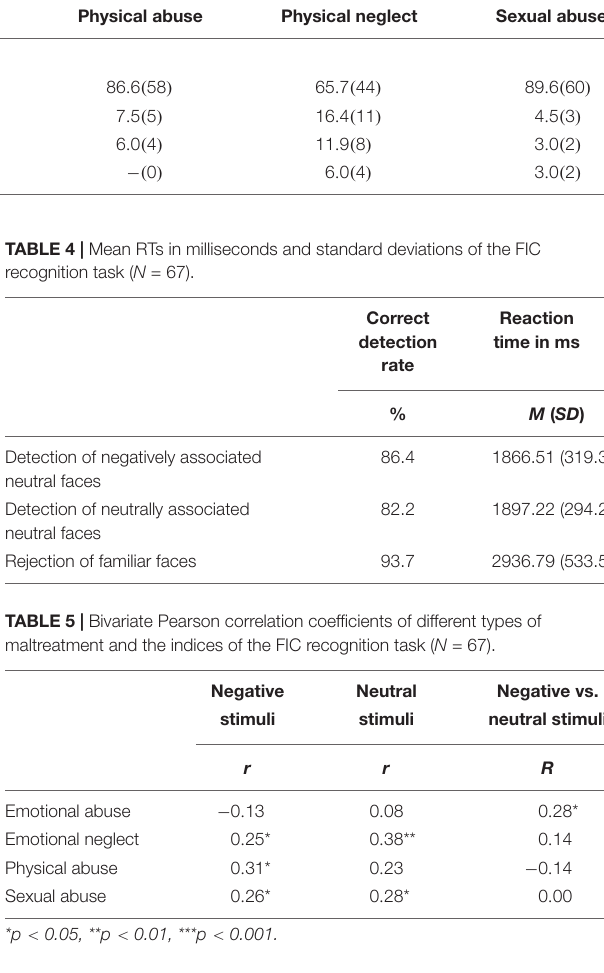
TABLE 2 | Frequency of abuse and neglect when applying severity cut-off scores established by Bernstein et al. (2003). CTQ scale